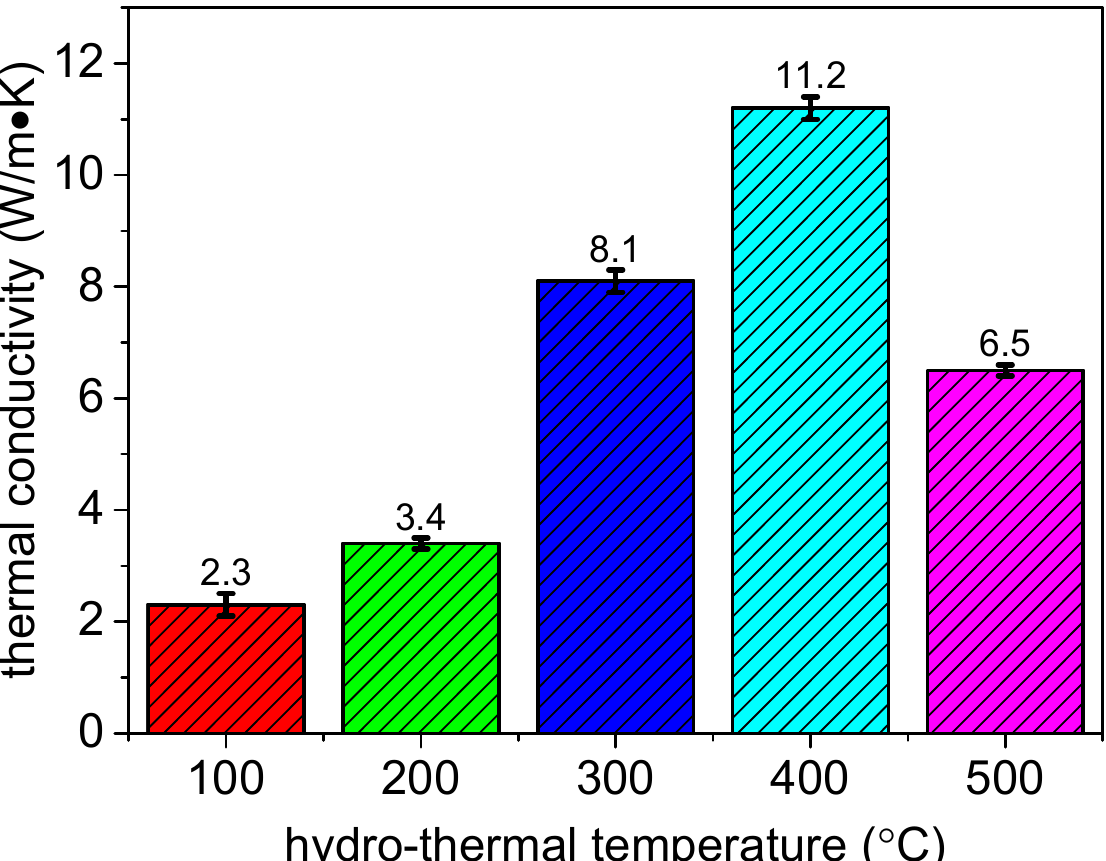
Figure 10. Thermal conductivity of anodic coating before and after being treated by hydro-thermal technology at 200 °C, 300 °C, 400 °C, and 500 °C.